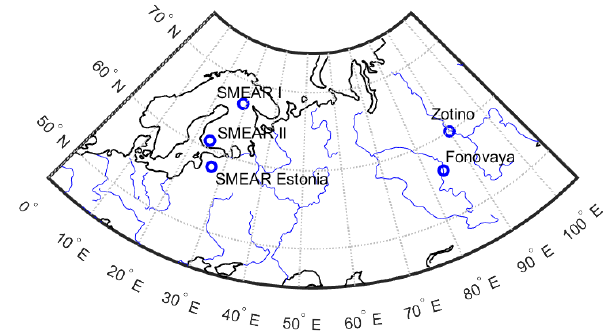
Figure 1. Location of the sites (see Table 1 for latitudes and longi- tudes of the different